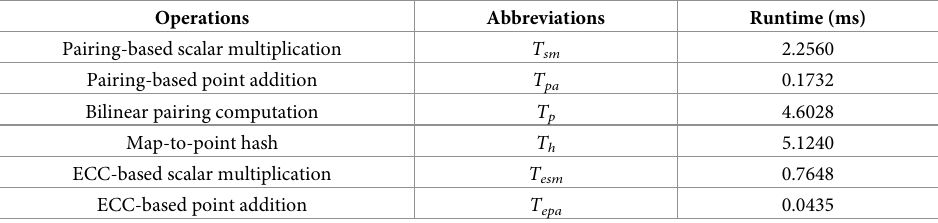
Table 2. Runtime of cryptographic operations.